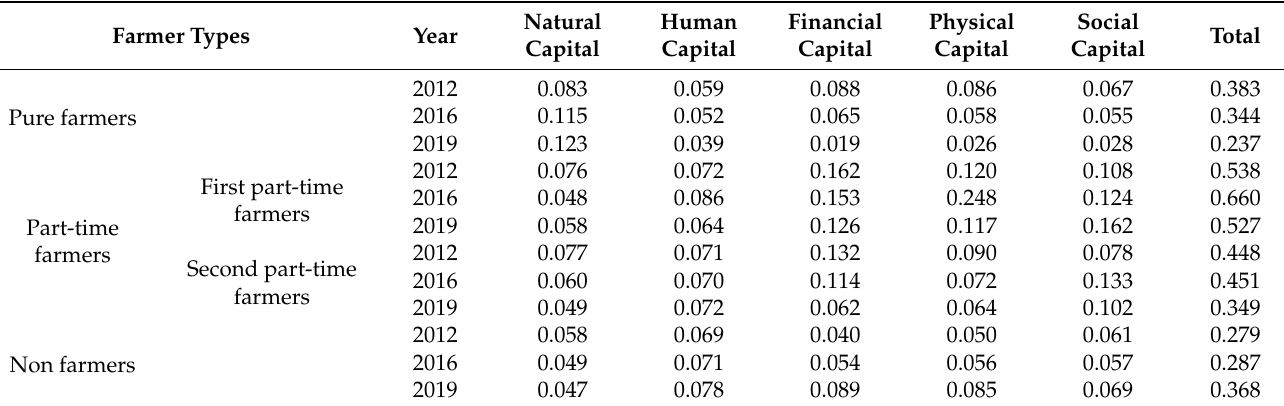
Table 3. Household livelihood capital index